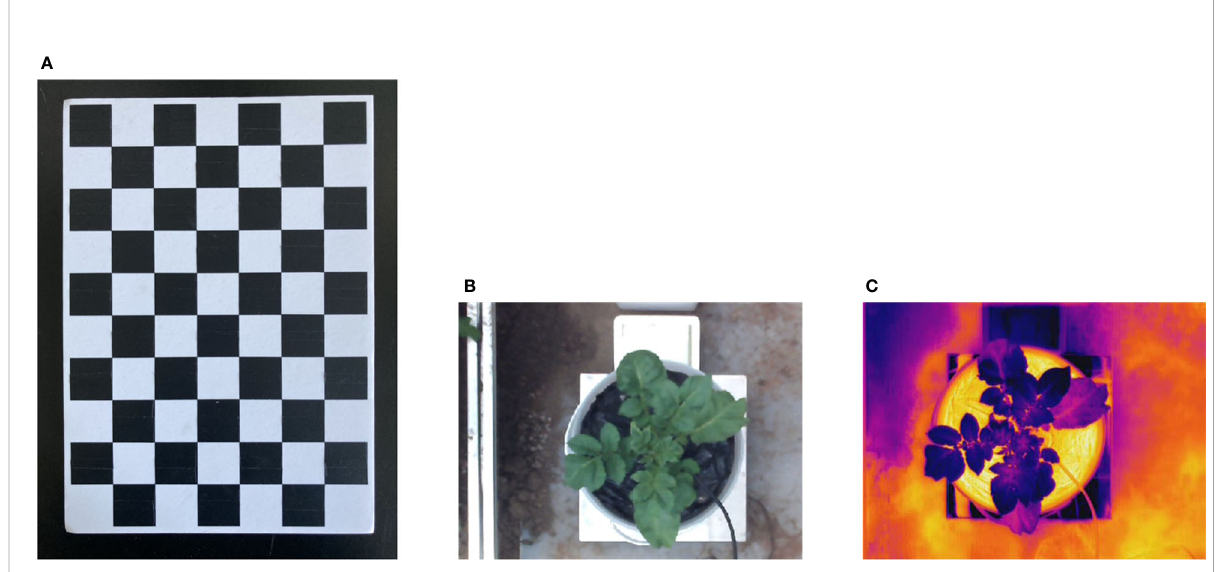
FIGURE 3 Images pre-processing and Checkerboard. (A) Checkerboard for stereo-calibration, (B) thermal image of the potato plant, (C) cropped and resized color image of the potato